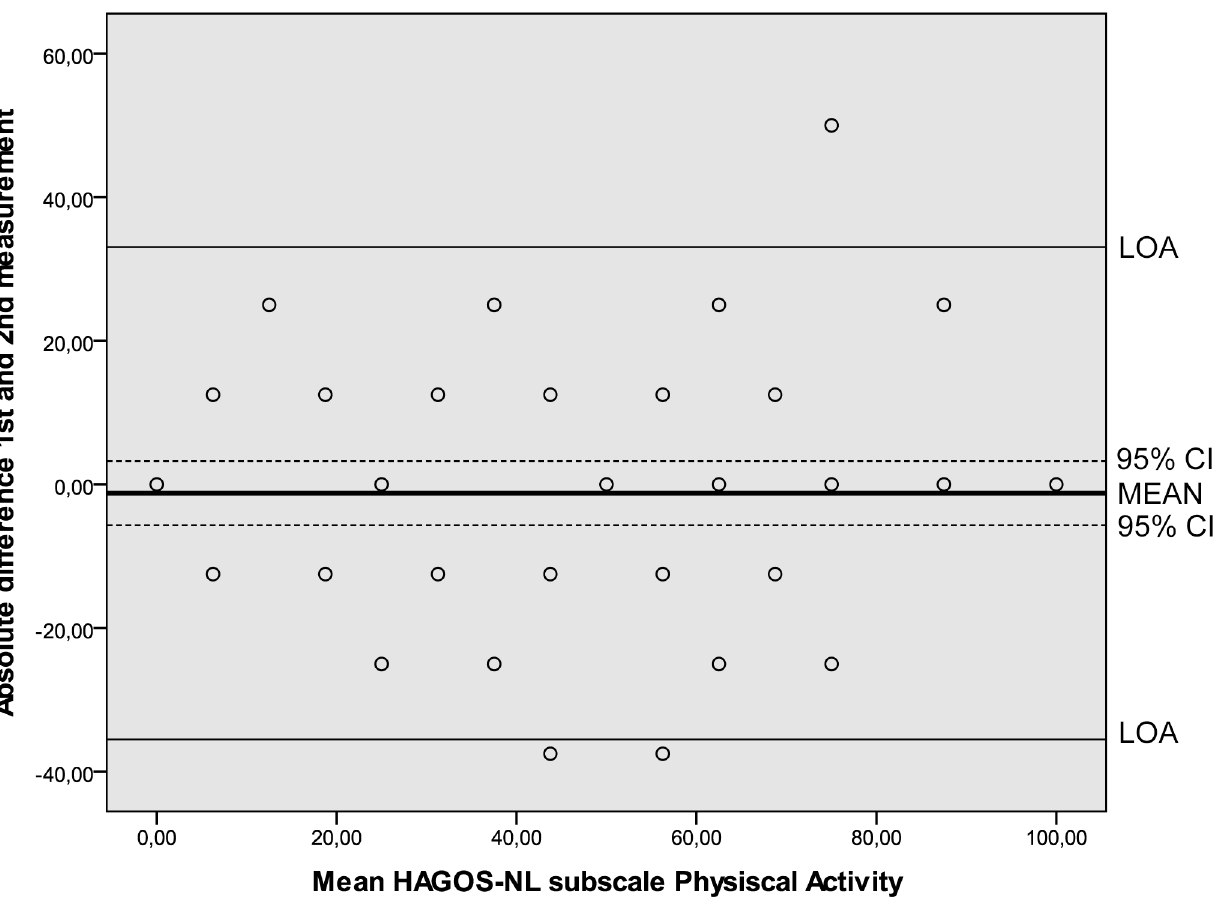
Fig 6. Bland and Altman graph of HAGOS subscale Functioning in physical activities . Abbreviations: HAGOS, Copenhagen Hip And Groin Outcome Score; LOA, limits of agreement; 95% CI, 95% confidenceinterval.